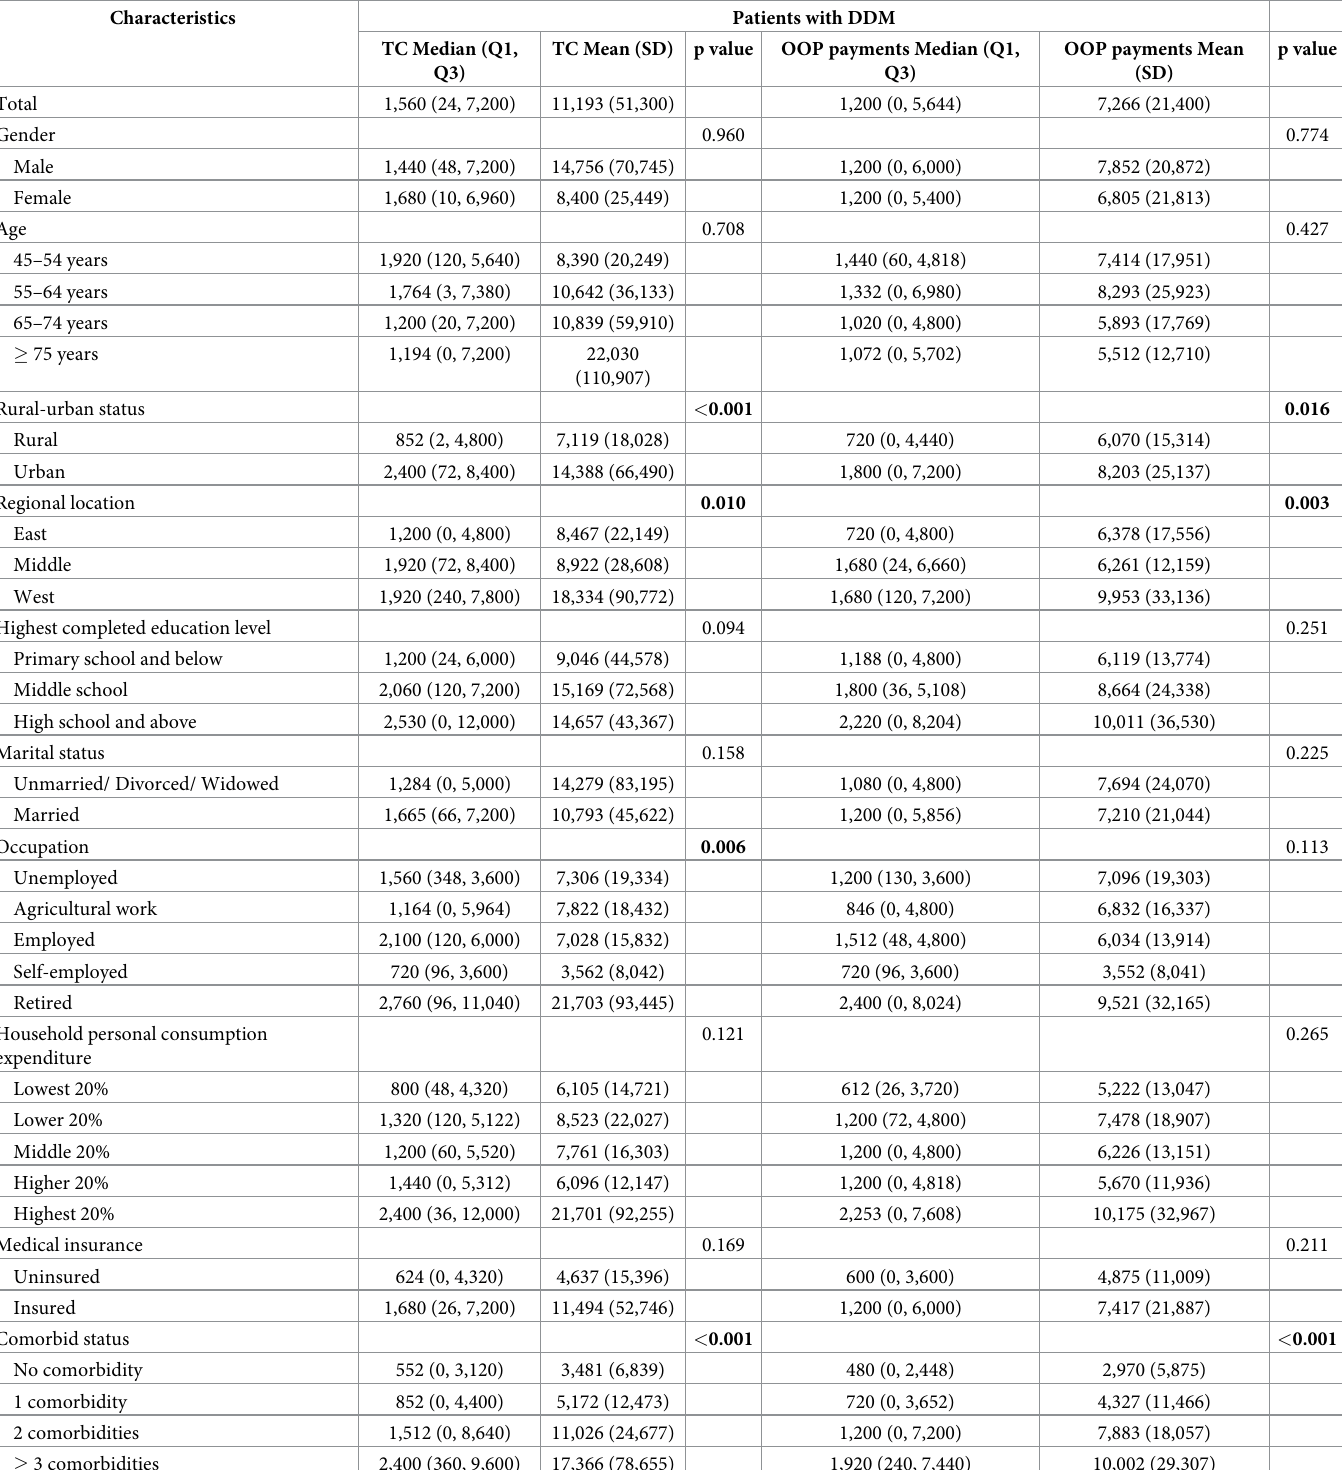
Table 2. TC and OOP payments in the population with DDM in the CHARLS 2011 study.